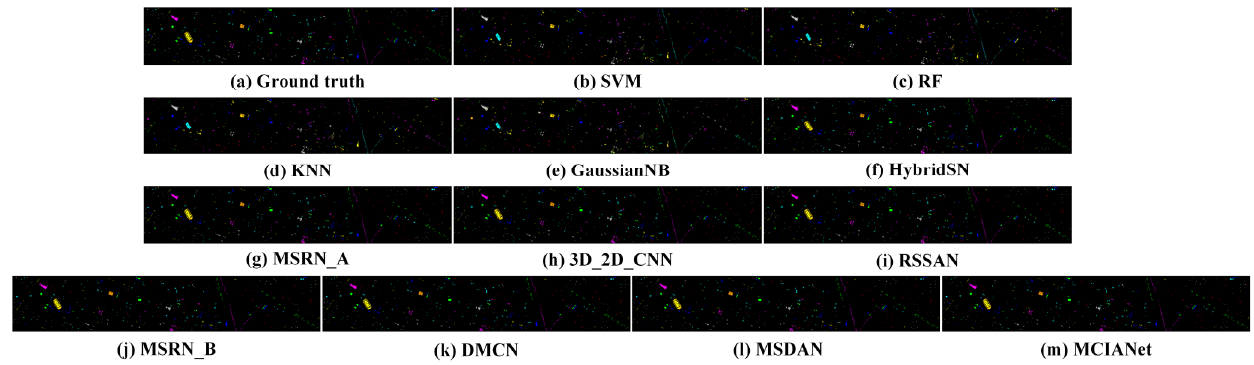
Figure 5. The classification visual maps on IP dataset.